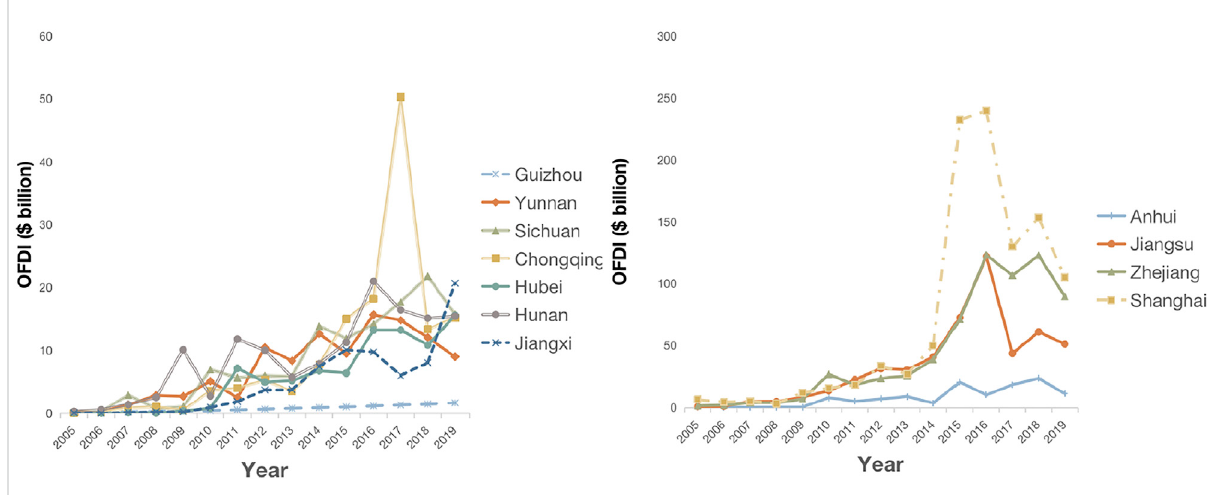
FIGURE 2 Scale of OFDI in Yangtze River basin, 2005 – 2019.